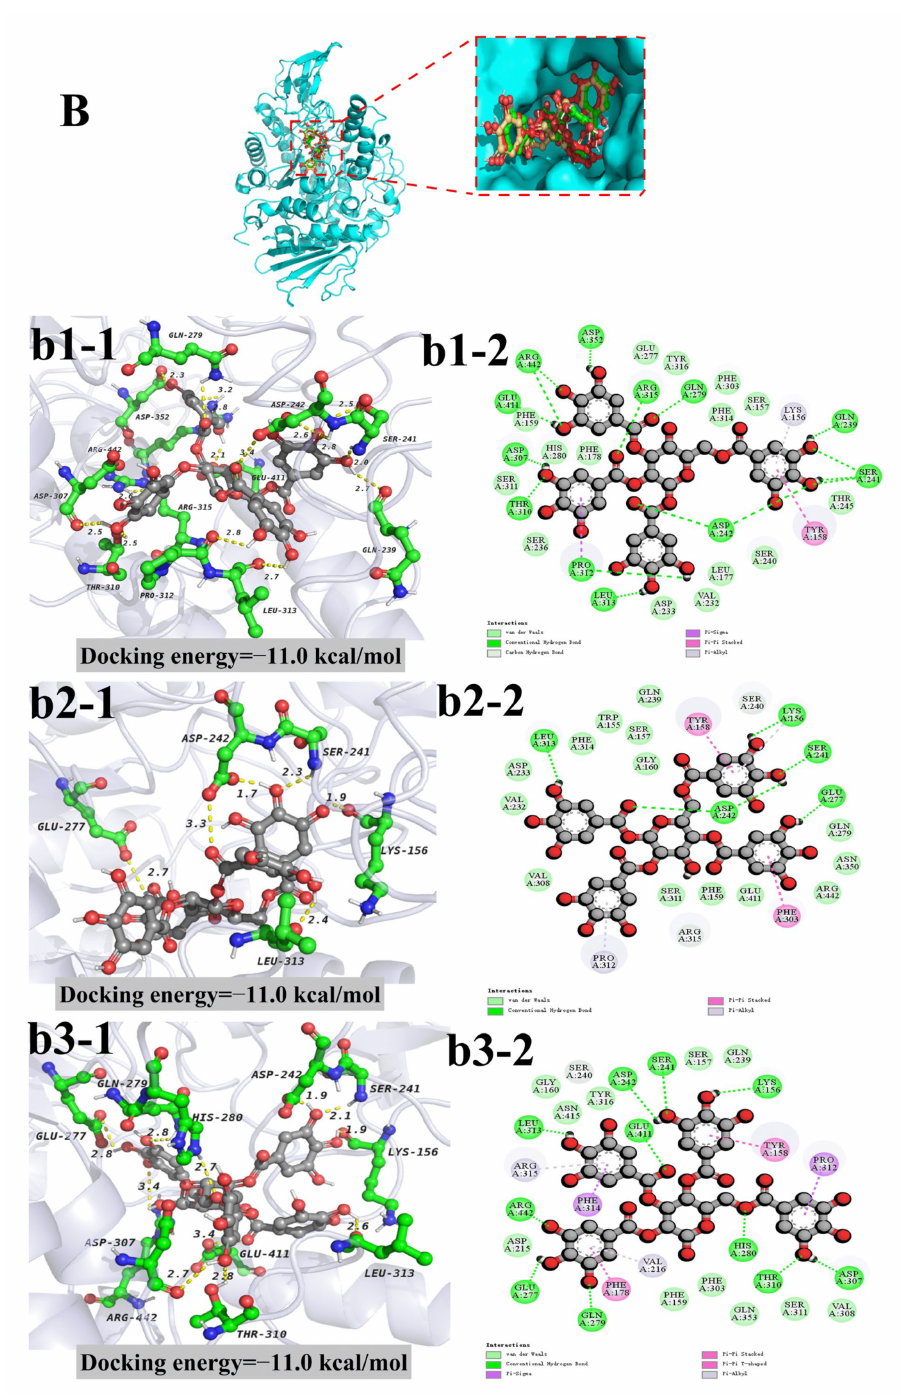
Figure 5. Molecular docking results of three different structures of trigalloylglucose ( A ) and three dif- ferent structures of tetragalloylglucose ( B ) with α -glycosidase complexes. ( A , B ) The pocket positions of the three compounds that bind to α -glycosidase. ( a1 – a3 ) Hydrogen bonding and hydrophobic inter- actions formed by 1,2,3-trigalloylglucose ( a1 ), 1,2,6-trigalloylglucose ( a2 ) and 1,3,6-trigalloylglucose ( a3 ) with α -glycosidase conformation diagram. Additionally, ( b1 – b3 ) hydrogen bonding and hy- drophobic interactions formed by 1,2,4,6-tetragalloylglucose ( b1 ), 1,2,3,6-tetragalloylglucose ( b2 ) and 2,3,4,6-tetragalloylglucos ( b3 ) with α -glycosidase conformation diagram. The ( a1-1 – a3-1 , b1-1 – b3-1 ) represent the 3D conformation of the hydrogen bond, while ( a1-2 , a2-2 , a3-2 , b1-2 , b2-2 , b3-2 ) repre- sent the 2D conformation of the hydrogen bond with hydrophobic interactions,